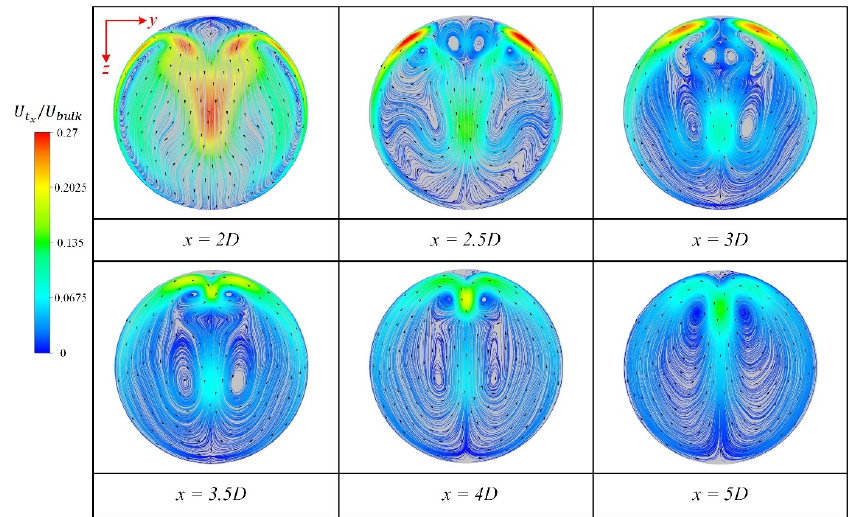
Figure 8. Streamlines and tangential velocity vectors downstream the second bend in Case-180°-3D .